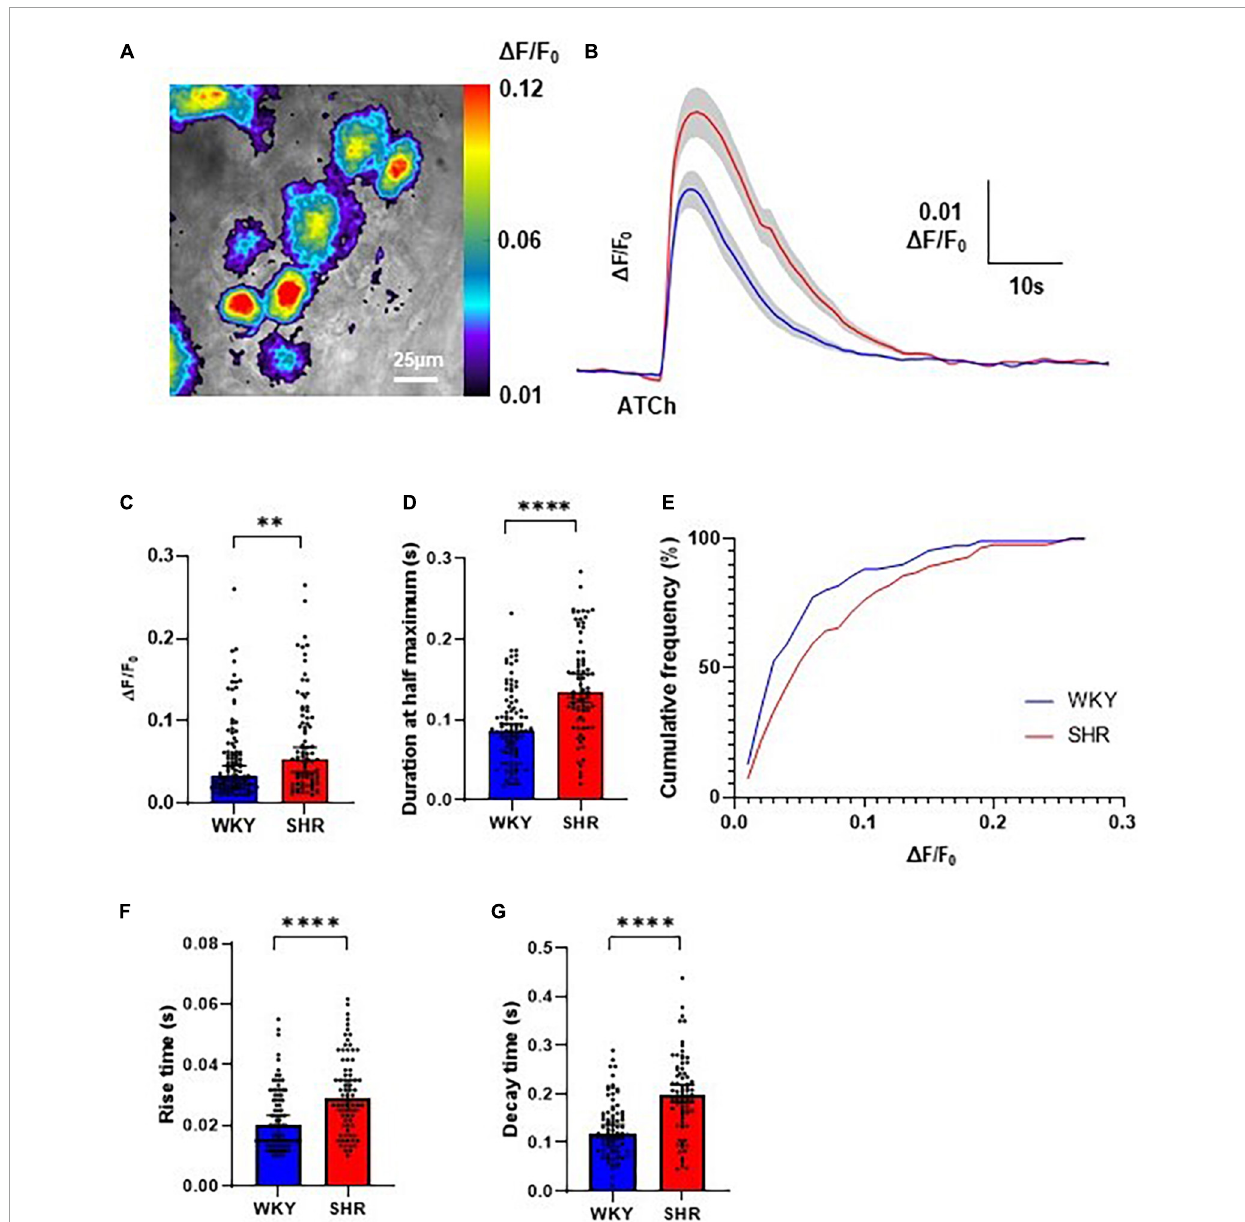
FIGURE2 Evoked Ca 2 + responses to acetylthiocholine (ATCh) application in Wistar Kyoto (WKY), and spontaneously hypertensive rat (SHR) ganglionated plexi (GP) neurons. (A) Example pseudo colour image of the fluorescent Ca 2 + responses of SHR GP neurons to locally applied ATCh (200 ms, 500 µ M). (B) Mean traces of SHR (red) and WKY (blue) neurons with ± SE highlighted in gray. (C) The peak amplitude (median ± 95% CI; Mann-Whitney test ∗∗ p < 0.01) and (D) duration at half maximum (median ± 95% CI; Mann-Whitney test ∗∗∗∗ p < 0.0001) of the evoked Ca 2 + responses. (E) Cumulative frequency plot of response peak amplitude in WKY (blue) and SHR (Kolmogorov-Smirnov test) (red; 4 WKY, 95 cells; 4 SHR, 80 cells). (F) The rise time (s) (median ± 95% CI; Mann-Whitney test ∗∗∗∗ p < 0.0001) and (G) decay time (median ± 95% CI; Mann-Whitney test ∗∗∗∗ p < 0.0001) of the fluorescent calcium response of SHR (red) and WKY (blue) GP neurons to locally applied ATCh (200 ms 500 µ M) (four WKY, 95 cells; four SHR, 80